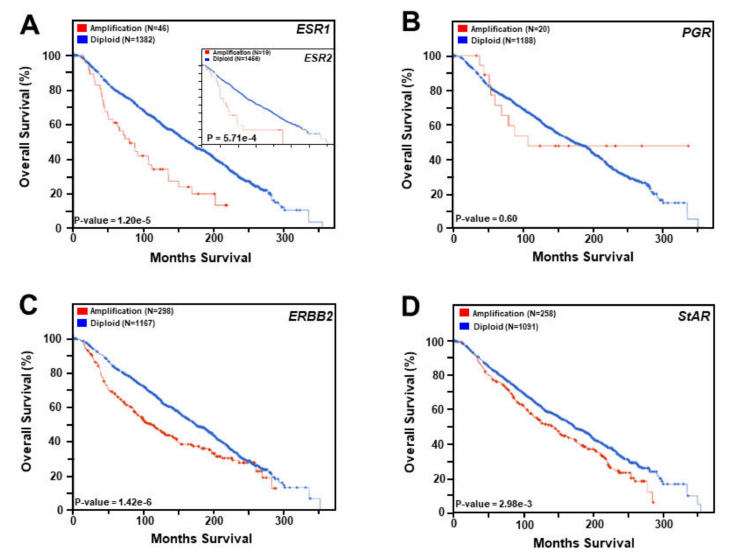
Figure 4. Amplification of ESR1 , ERS2 , PGR , EBBR2 , and StAR genes in BC tumors and their correlation to overall survival. TCGA METABRIC breast tumor samples (N = 2173) were utilized for survival analyses. Kaplan-Meier survival curves were generated with or without amplification of the following genes: ESR1 ( A ), ERS2 ( A , inset), PGR ( B ), EBBR2 ( C ), and StAR ( D ). Overall survival rate of BC patients was assessed with ‘amplification’ and ‘diploid’ of these genes. Red and blue lines in the Kaplan-Meier plots reflect BCs with amplification and diploid status of these genes,